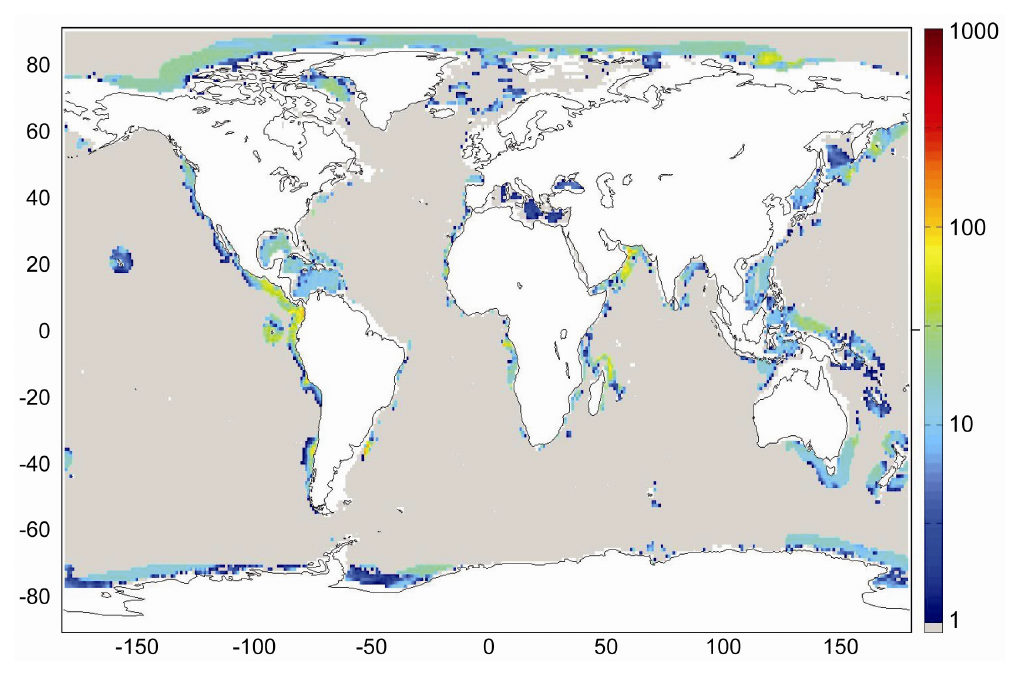
Figure 31. Global distribution of methane hydrate in marine sediments. The map was calculated applying complete compaction [Equation (32)] and Quaternary burial